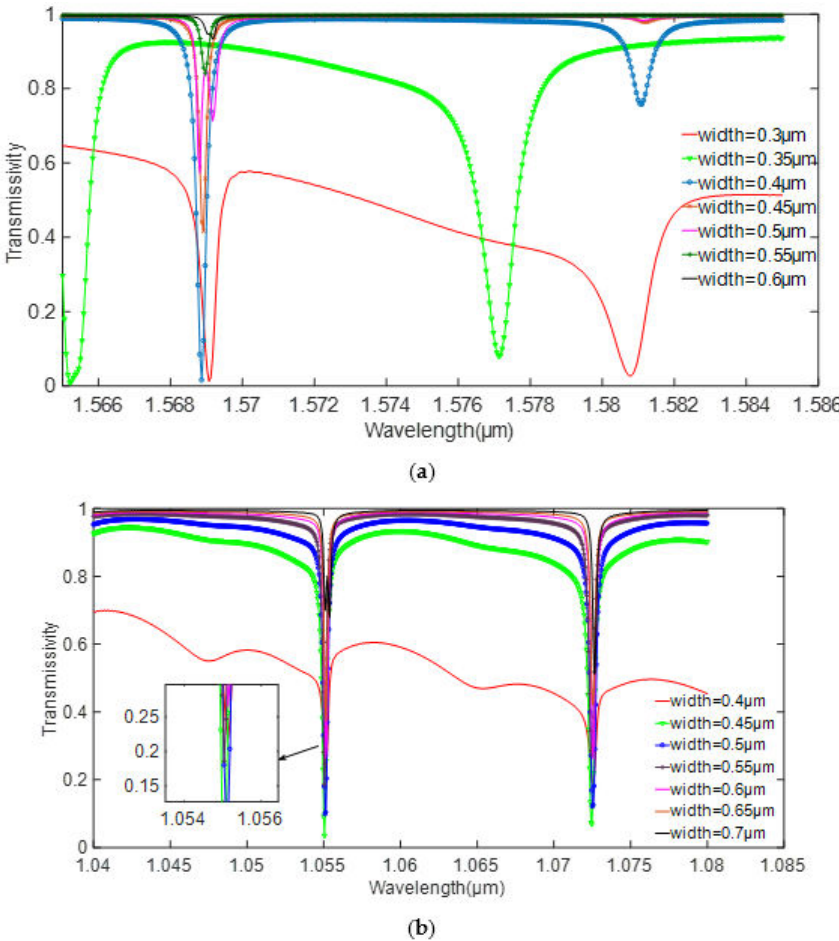
Figure 8. Relationship between the transmissivity and waveguide width. ( a ) silicon. ( b ) silicon